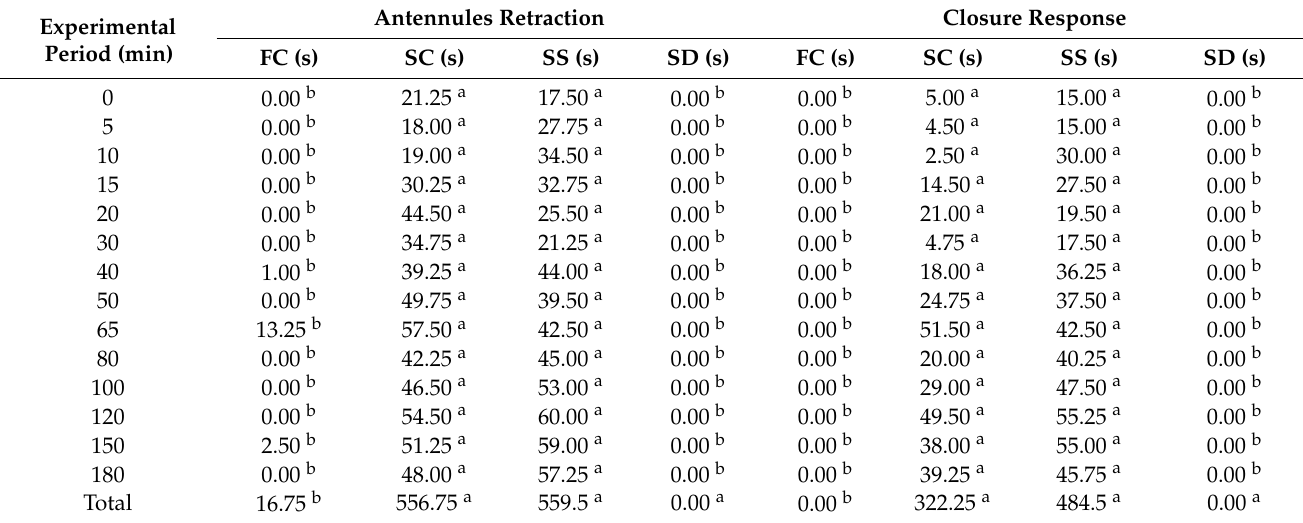
Table 2. The average time (s) of antennules retraction and closure response in Eriocheir sinensis during 3 h exposure in four treatment groups (FC: freshwater control group; SC: salinity control group; SS: salinity surge group; SD: salinity dip